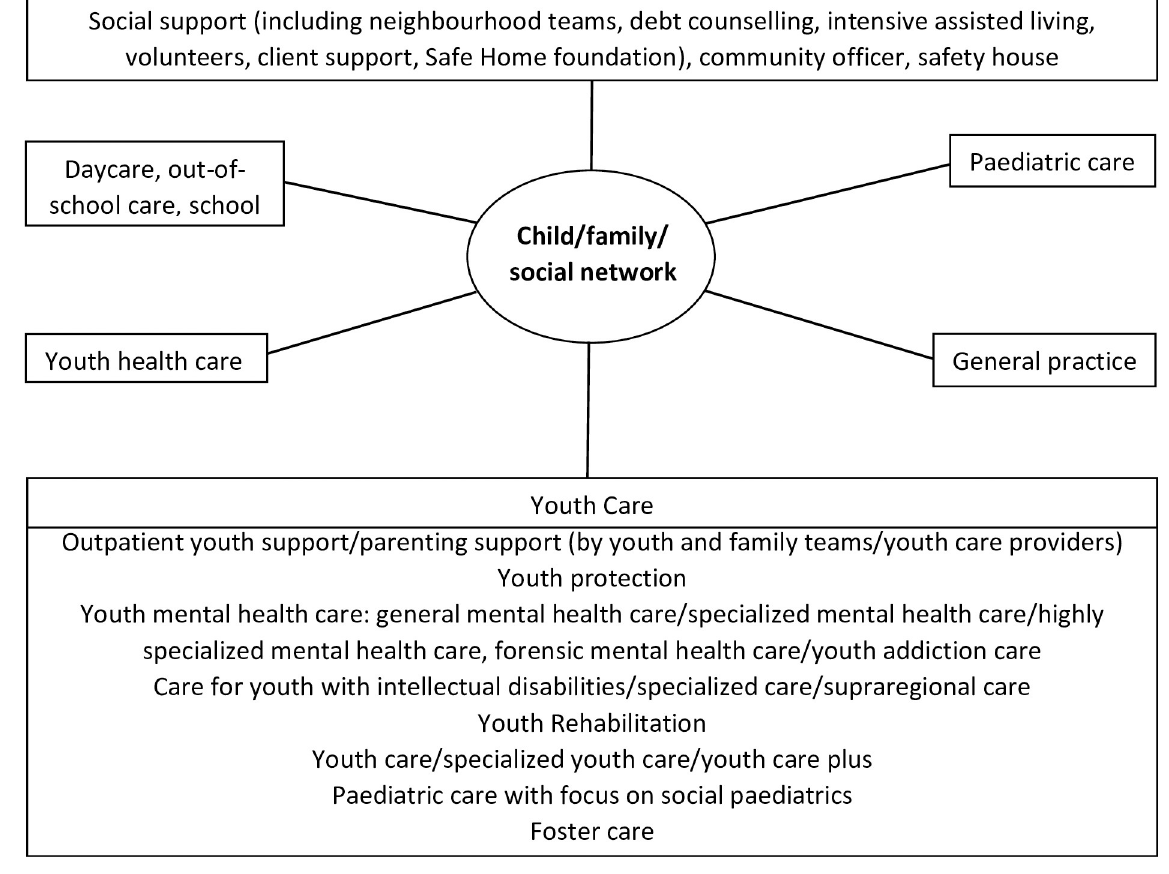
Fig 1. Simplified overview of the Dutch youth care system in relation to the social and medical domains concerning a child and its family and/or social network 1 . 1 Figure derived from: Akwa GGZ [Internet]. Utrecht; c2022 [cited 2022 Feb 21]. Generieke module Samenwerkingsafspraken (jeugd); [about 9 screens]. Available from: https://www.ggzstandaarden.nl/generieke-modules/landelijke- samenwerkingsafspraken-jeugd-ggz/inleiding/doelstelling-van-deze-standaard (in Dutch).